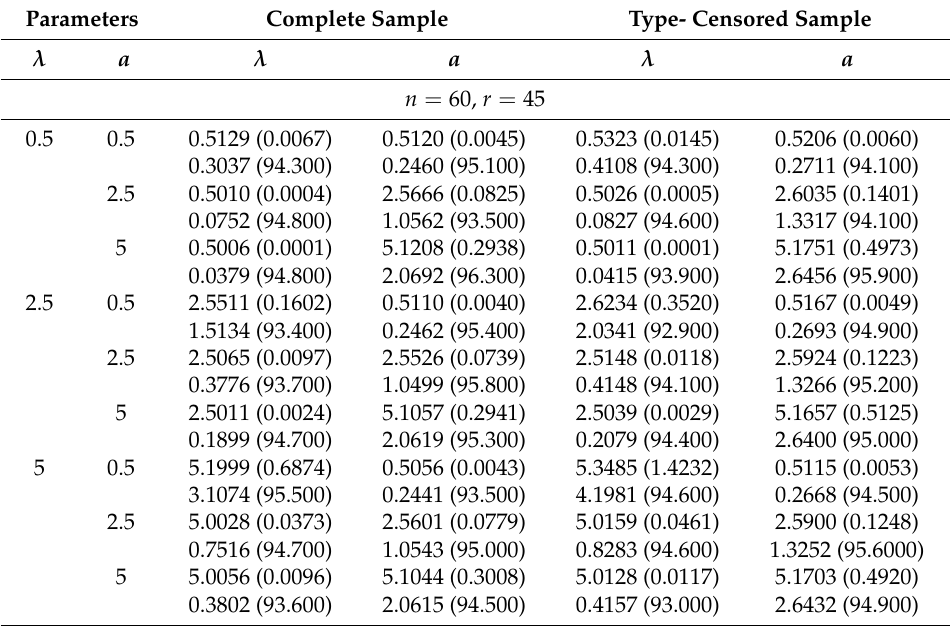
Table 3. The AVs of estimates and corresponding MSEs (in parentheses) in the first row and the CIL and corresponding coverage probability (in parentheses) in the second